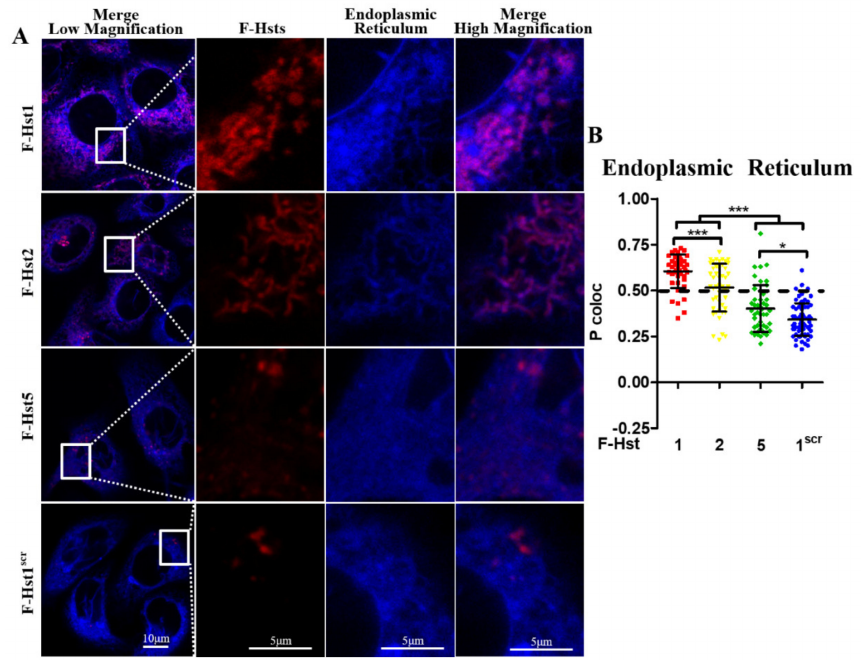
Figure 3. F-Hst1, F-Hst2 and F-Hst5 were targeted to endoplasmic reticulum (ER). ( A ) CLSM images showed F-Hst1, F-Hst2 and but not F-Hst5 or F-Hst scr (in red) showed co-localization with ER (in blue). ( B ) The Pearson’s correlation analysis showed that F-Hst1 and F-Hst2 co-localized with ER (with P coloc values of 0.60 and 0.51, respectively), while but not F-Hst scr or F-Hst5 did not show significant co-localization with mitochondria. Data were presented as mean ± SD. *: p < 0.05; ***: p < 0.001.